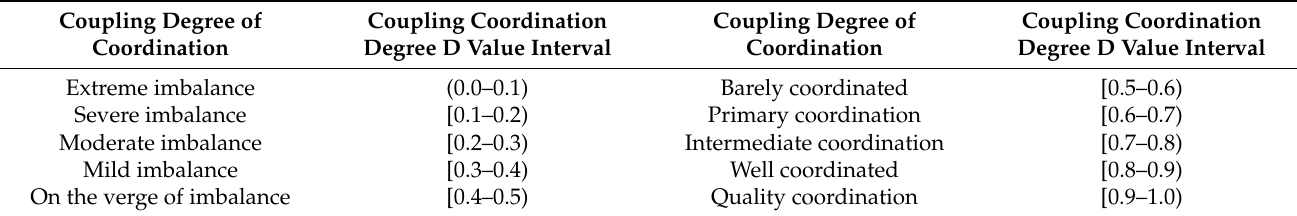
Table 2. Classification of coupling and coordination degree of PREE system. Source: modified based on Table 1 in Chen et al.